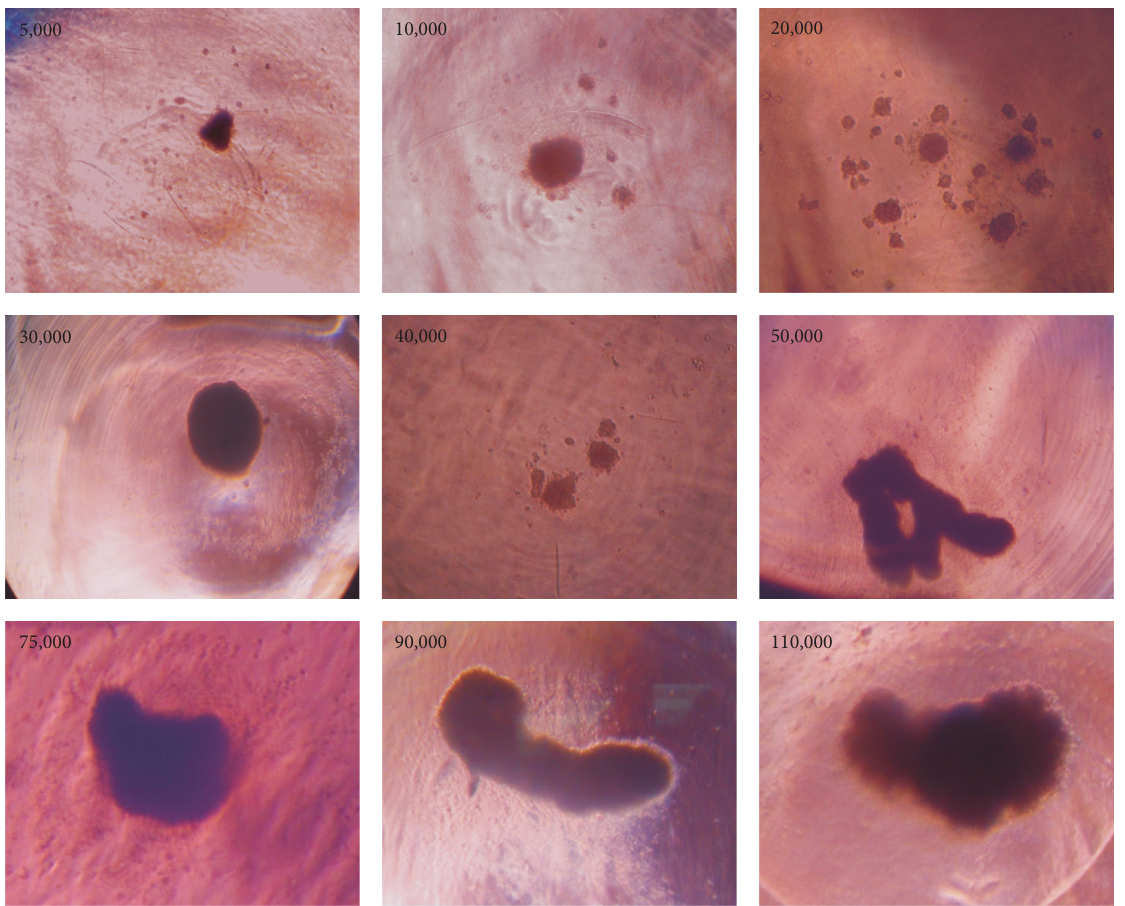
Figure 1: Optical microscopy of MC3T3-E1 aggregates, at day 7, developed with different cell densities (20x objective).